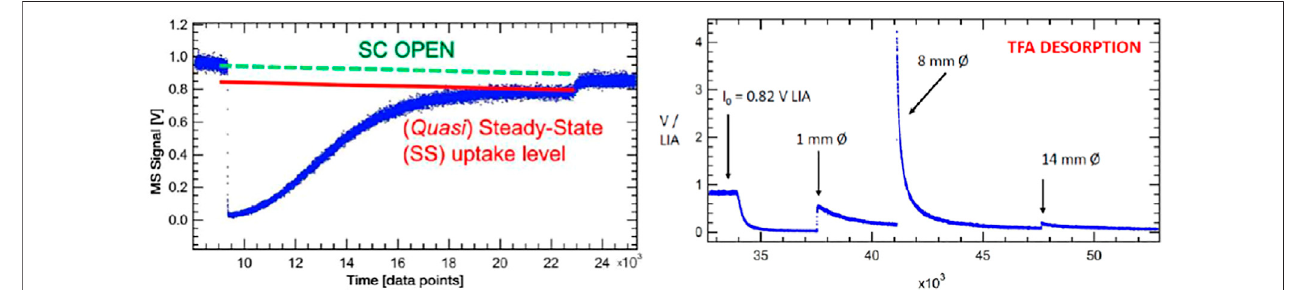
FIGURE 7 | Adsorption and desorption traces for tri fl uoroacetic acid monitored at m/e = 69 amu at F i = 1.36 × 10 15 molecule s − 1 reacting with 4.8 mg Processed AmorphousCarbon(PAC)of1,580 m 2 /gBETsurface(S101).Uptakephase:integraloftheblueMStraceandtheredlinecorrespondsto5.35%ofamonolayeroratotal of 1.4 × 10 18 molecules with a steady-state rate constant of 1.2 × 10 − 2 s − 1 . SC closed at 22 ′ 700 pts. The recovered TFA fraction from the desorption amounts to 1.3 × 10 18 molecules or 92.9% of the quantity taken up. Computer fi t for the 1 mm Ø exit ori fi ce KFR results in k d = 1.2 × 10 − 4 s − 1 with k a = 2.3 s − 1 , k e = 0.114 s − 1 (See Figure 6 , lower